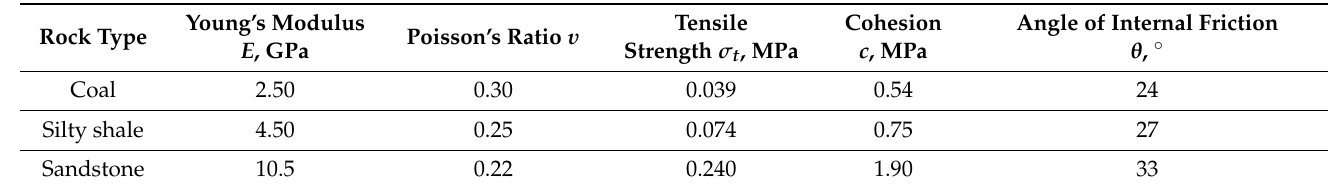
Table 1. Mechanical parameters of the rock mass in the area of the analysed longwall panel adopted for numerical calculations.